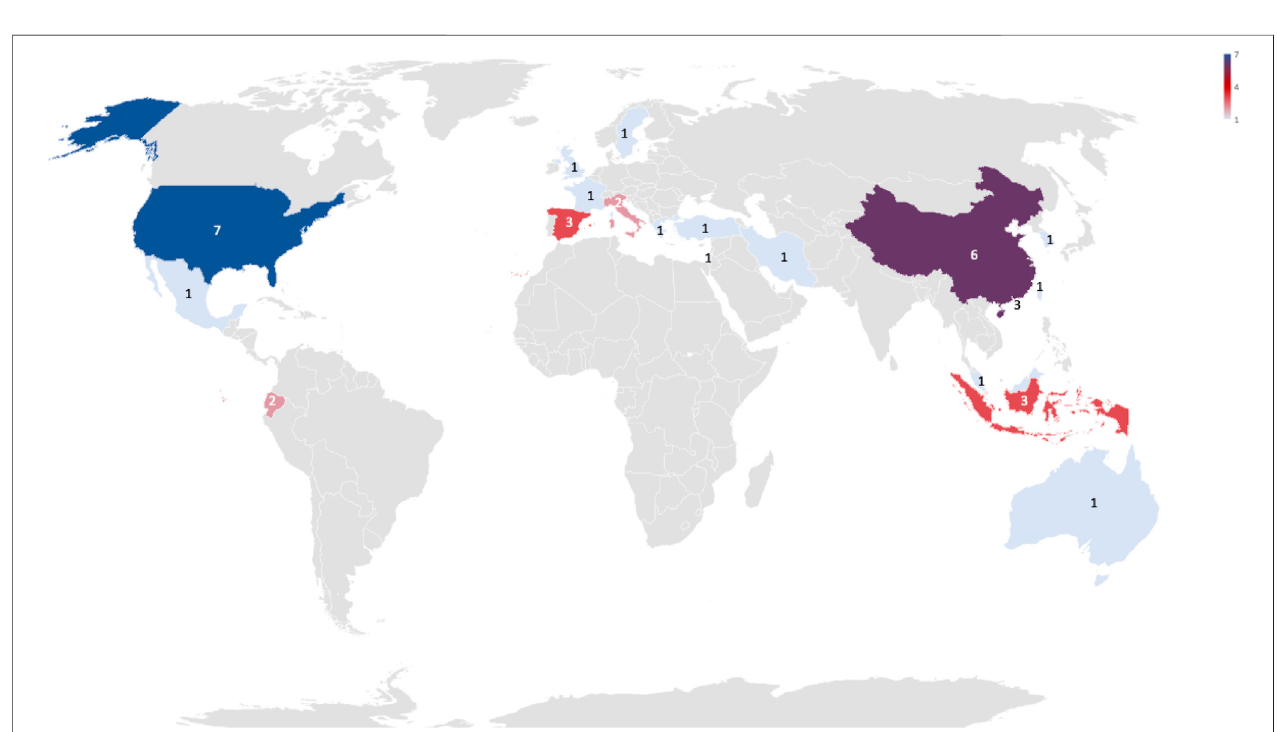
FIGURE 5 | The number of collected papers across different regions/countries of fi rst